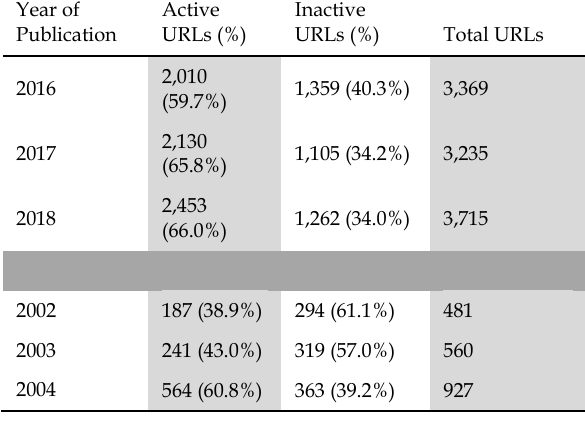
Table 6: Number and Percentage of active and inactive URLs by year of journal publication (2007 vs. 2021) Year of Publication